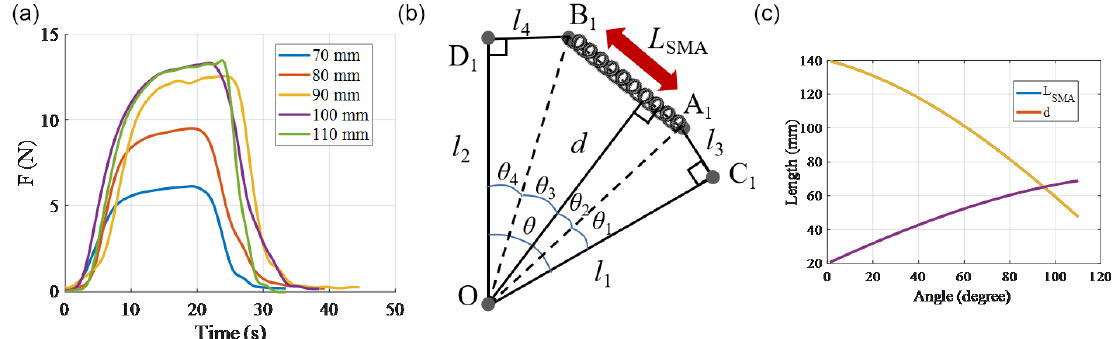
Figure 3. Contraction force test and torque calculation of SMA springs. (a) The experimental results of the relationship between contraction force and pre-stretched length of SMA springs. (b) The geometric relationship between SMA springs and a human arm. (c) d and L SMA changing with the movement angle of